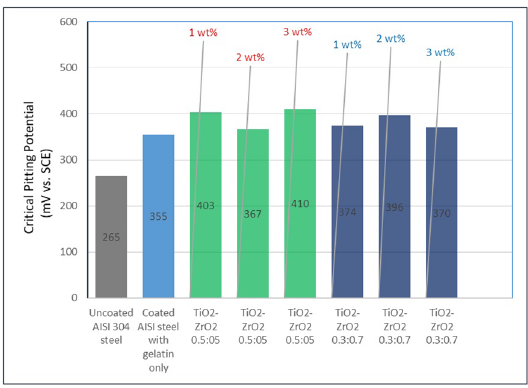
Figure 12 : Critical pitting potential behavior of the AISI 304 steel coated with hybrid TiO